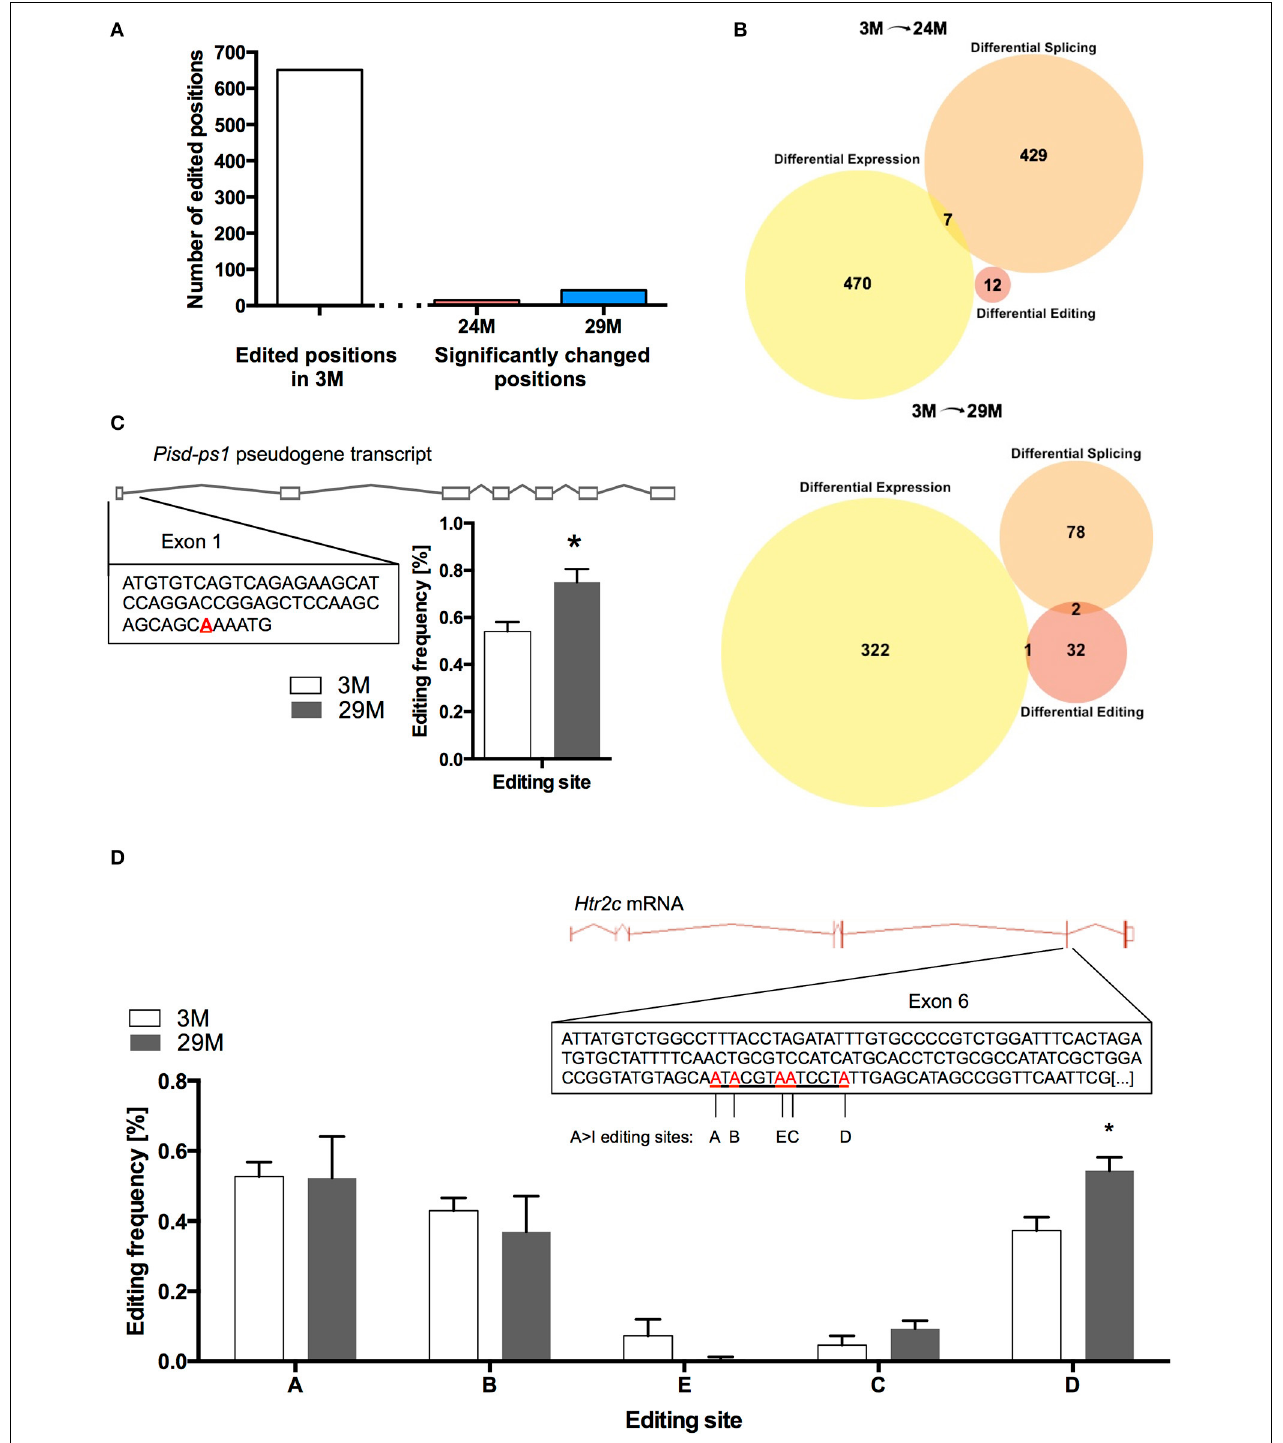
FIGURE 5 | RNA editing in the aging hippocampus. (A) Total number of RNA-editing events detectable in the hippocampus of 3-month-old mice and number of changes occurring during aging. (B) Venn diagram showing the overlap of differentially expressed genes, genes affected by splicing and RNA-editing in 24-month-old mice (upper panel) and 29-month-old mice